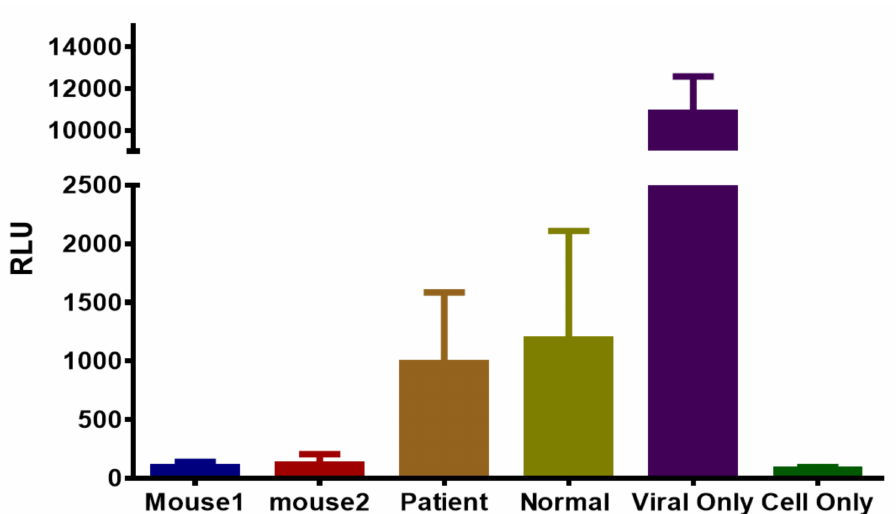
Figure 6. Results of neutralization assay of mouse and human plasma. Mouse1 was selected from the peptide mixture 1 group with the QS21 adjuvant; Mouse2 was from the peptide mixture 1 group with the Al(OH) 3 adjuvant; Patient is human plasma from a recovered COVID-19 infected patient; Normal is human negative plasma; Viral Only consists of the viral infected cells without adding plasma; Neg Ctr is cell only (N = 4 per group).